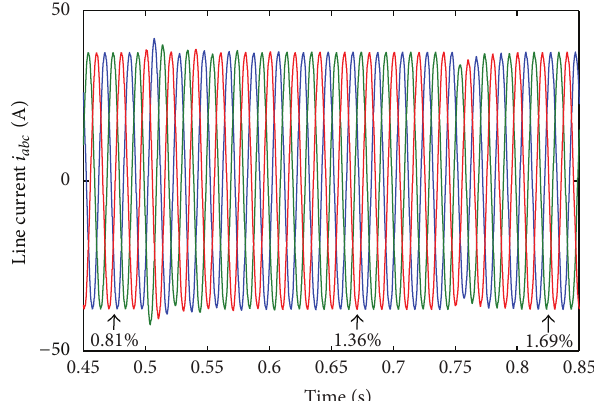
Figure 18: Optimal switching angles response to DC sources